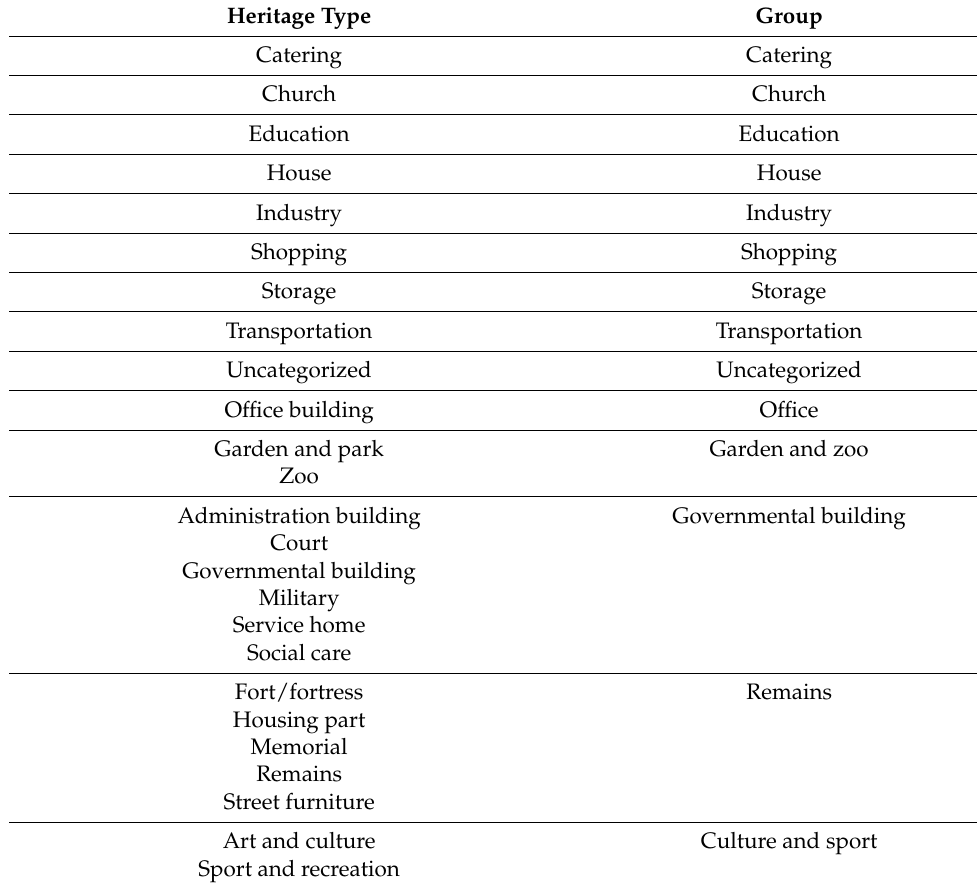
Table 1. Heritage classification.